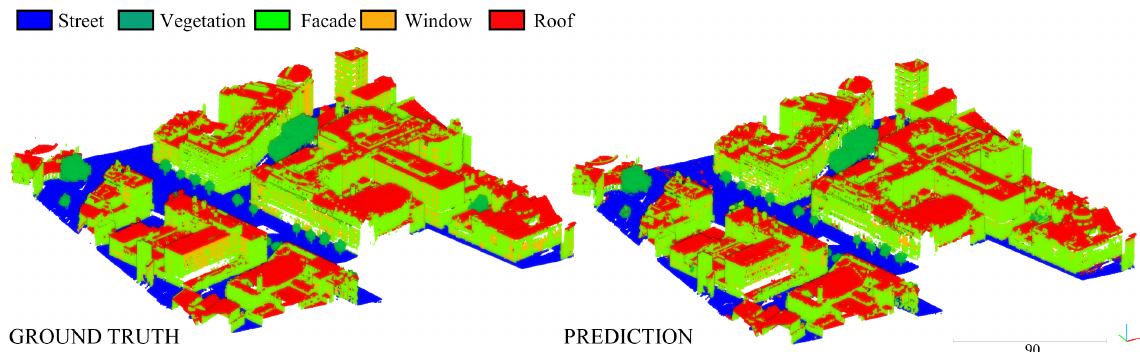
Figure 8. Visual comparison between the hand-annotated Dublin dataset (left) and the prediction achieved using the proposed method (right).